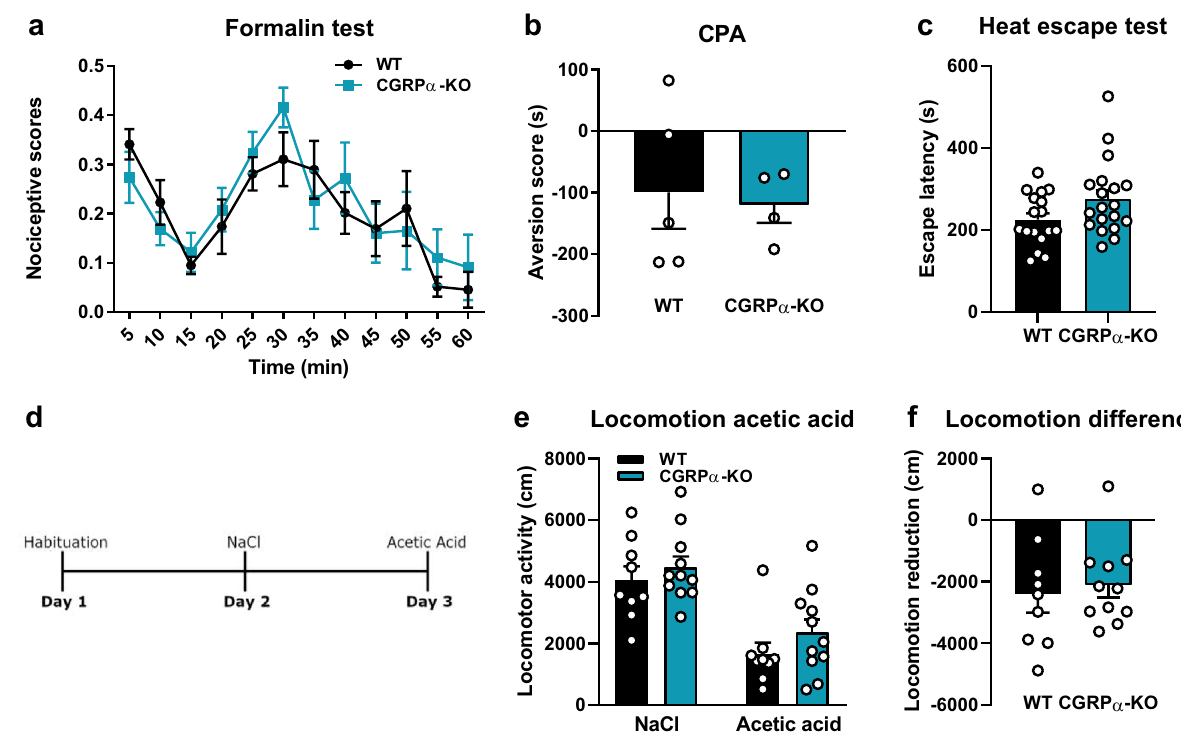
Figure 4. Nociceptive behaviors in αCGRP-KO mice. ( a ) WT and αCGRP-KO mice showed similar responses to inflammatory pain in the formalin test. One-way RM ANOVA: time: F (11, 120) = 6.52, p < 0.0001; genotype: F (1, 120) = 0.351, p = 0.555; interaction: F (11, 120) = 0.638, p = 0.793; n = 6 in both groups. ( b ) Conditioned place aversion to thermal pain was similar in αCGRP-KO and WT mice. T-test: p = 0.79; WT n = 5, αCGRP-KO n = 4. ( c ) No statistically significant difference in escape latency was seen between the genotypes in the heat escape test. T-test: p = 0.06; WT n = 17; αCGRP-KO n = 19. ( d ) Timeline of the acetic acid locomotion test. ( e ) No genotype difference was seen in locomotor activity after intraperitoneal injection of saline or 0.6% acetic acid. ( f ) αCGRP-KO and WT mice show similar reduction in locomotion following acetic acid injection compared to after saline injection. WT n = 9; αCGRP-KO n =